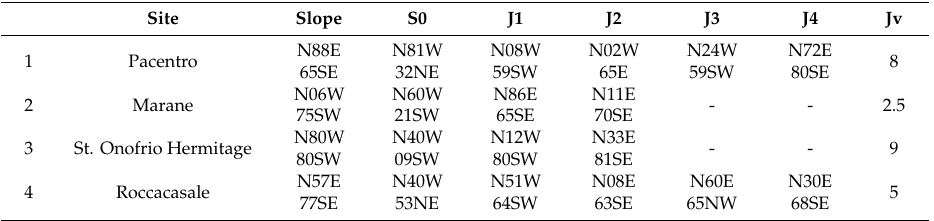
Table 2. Geomechanical investigation data: Slope orientation, strata attitude (S0), and main joints (J1,2,3,4) analyzed (for investigation sites’ locations, see Figure 11); estimated Jv (joint / m 3 ) for each site.